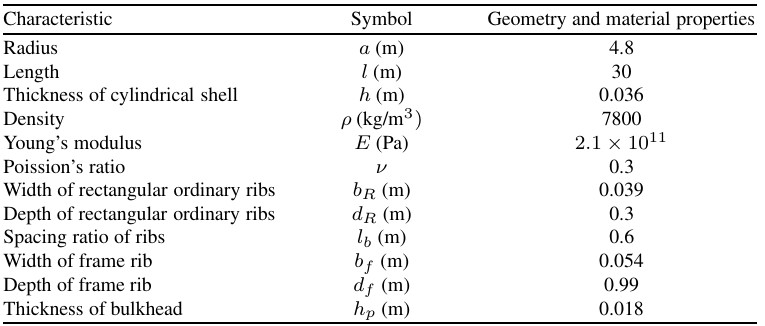
Table 1 Geometry dimensions and material properties of computation models